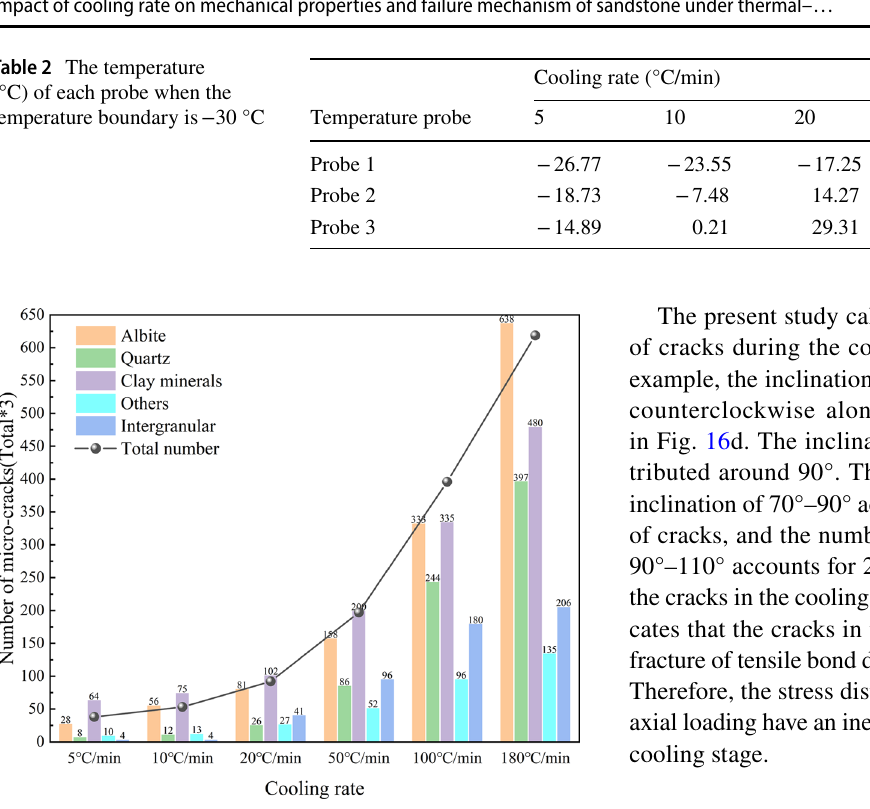
Fig. 15 Number of microcracks in the cooling